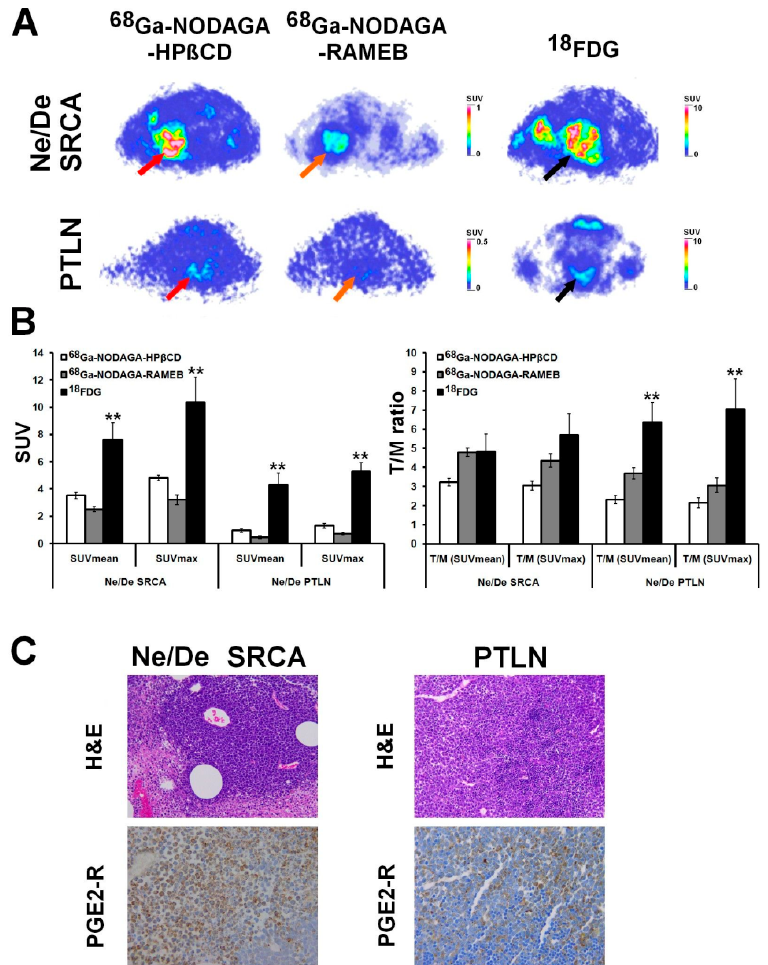
Figure 4. PET imaging of primary tumors and metastases using 68 Ga-labelled CDs. ( A ) panel: In vivo assessment of 68 Ga-labelled CDs ([ 68 Ga]Ga-NODAGA-HPBCD/ HP β CD—red arrows; [ 68 Ga]Ga-NODAGA-RAMEB—orange arrows), and [ 18 F]F-FDG (black arrows) accumulation of SRCA-induced Ne/De primary tumors and parathymic lymph node (PTLN) metastases using preclinical PET imaging. ( B ) panel: Quantitative SUV data analysis of the PET images. PET images and SUV data were obtained 8 days after the SRCA, and 50 and 90 min after the intravenous injection of [ 18 F]F-FDG and the 68 Ga-labelled probes, respectively. SUV values are presented as mean ± SD. ( C ) panel: Histological analysis of Ne/De primary tumors (SRCA) and PTLN metastasis. Upper row: hematoxylin-eosin (H&E) stained tumor tissue. Magnification: 20×. Lower row: Anti-Prostaglandin E Receptor EP2/PTGER2 antibody immunohistochemistry (PGE2-R), visualized with 3,3-diaminobenzidine (DAB) (brown staining). Magnification: 40×. Figures are from [35] with permission. CD: cyclodextrin; DAB: 3,3-diaminobenzidine; [ 18 F]F-FDG: Fluorine-18 labelled Fluorodeoxyglucose; 68 Ga: Gallium-68; NODAGA: 1,4,7-triazacyclononane-1-glutaric acid-4,7-diacetic acid; H&E: hematoxylin-eosin; HPBCD/HP β CD: hydroxypropyl- β -cyclodextrin; Ne/De: rat mesoblastic nephroma; PET: positron emission tomography; PGE2-R: Anti-Prostaglandin E Receptor EP2/PTGER2 antibody immunohistochemistry; PTLN: parathymic lymph node; RAMEB: randomly methylated beta-cyclodextrin; SRCA: subrenal capsule assay; SUV: standardized uptake value; SD: standardized uptake value. ** p < 0.01.